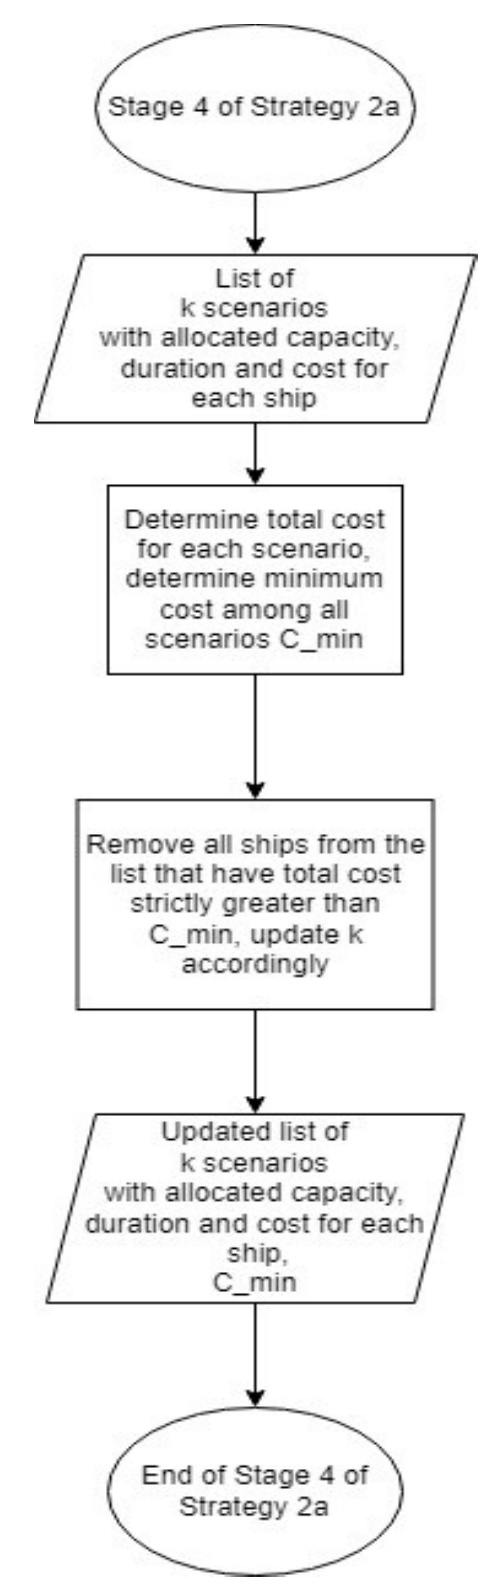
Figure 12. Flowchart for Stage 4 of Strategy 2a.